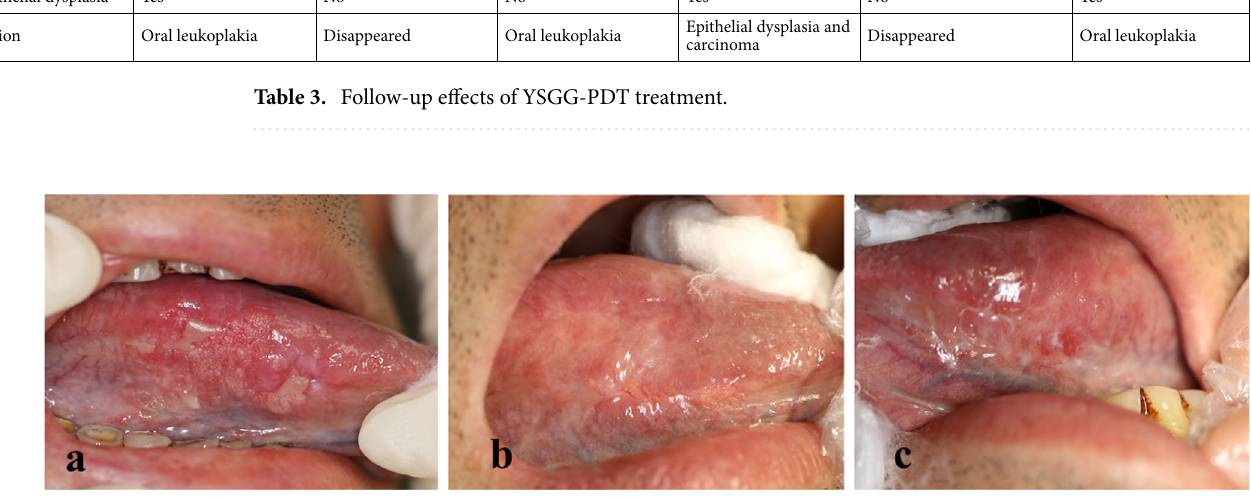
Figure 4. OL patients with severe dysplasia at t0 ( a ), t1 ( b ) and t2 ( c ), New lesions occured in new areas). The lesion changes at t0, t1, and t2 in YSGG-PDT treatment of OL patients with severe dysplasia were recorded by taking pictures.